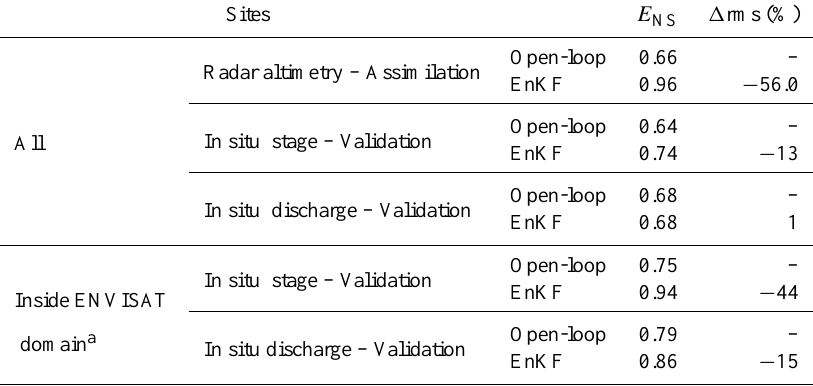
Table 2. As Table 1 but for Exp. 2.